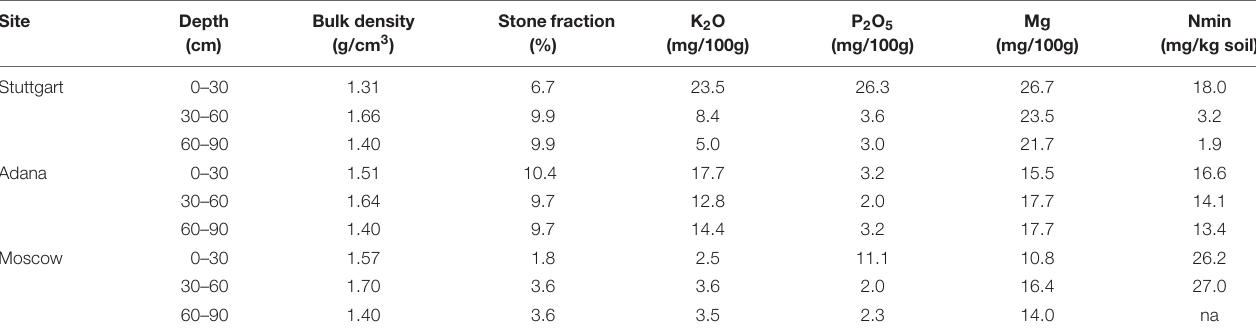
TABLE 2 | Bulk density, stone fraction, and nutrient status for different soil depths for each site.